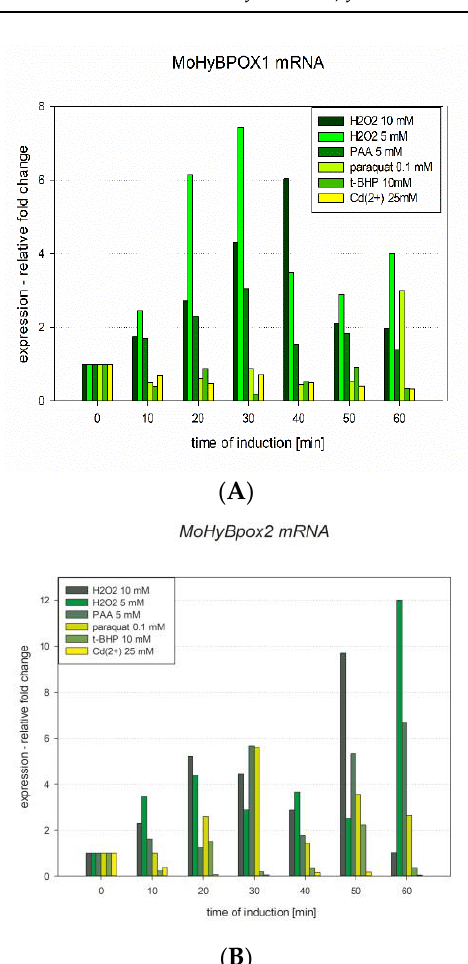
Figure 3. Inducible expression of two gene paralogs of hybrid peroxidase gene in Magnaporthe oryzae detected and quantified with RT-qPCR methodology: ( A ) time traces for changes in the production of MohyBpox1-mRNA with 5 different oxidative stress inducers using Mor4-specific transcript (Supplementary Table S1) and ( B ) time traces for changes in the production of MohyBpox2 -mRNA with 5 different oxidative stress inducers using Mor2-specific transcript (Supplementary Table S1).